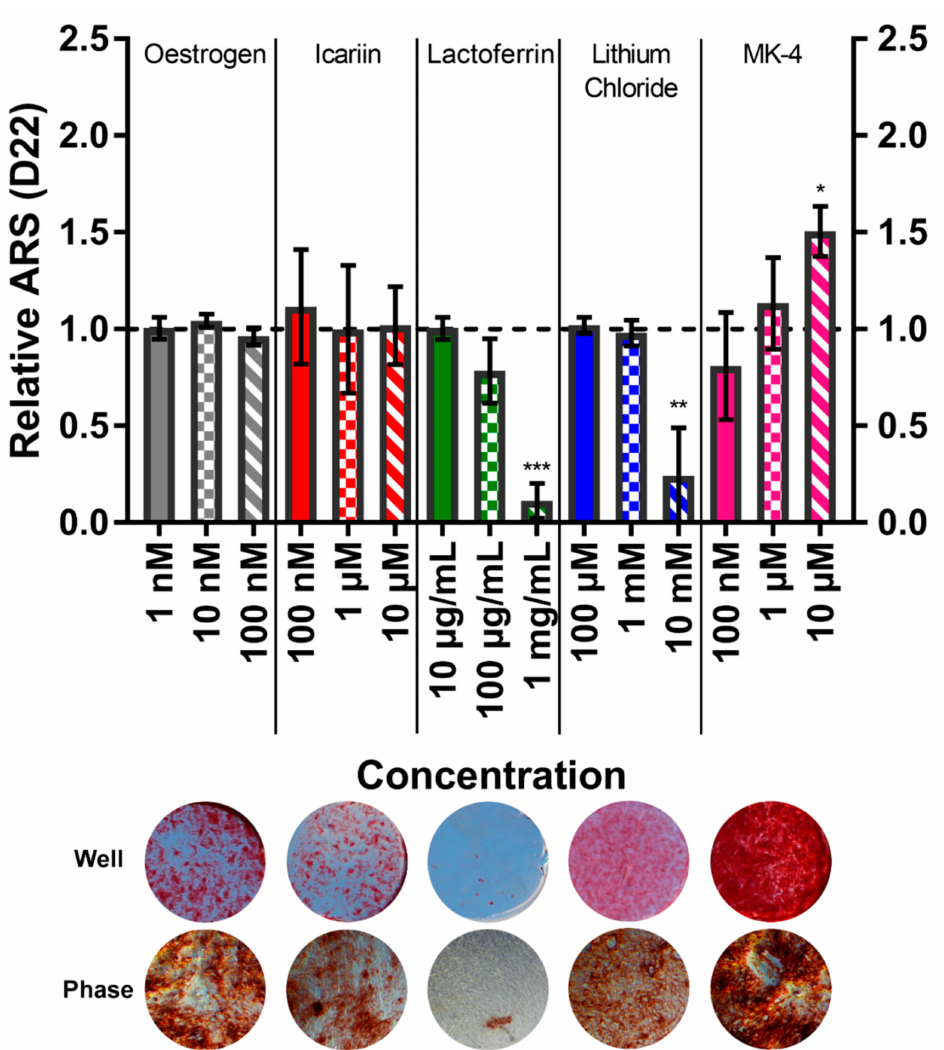
Figure 6. ( Top ) The e ff ect of each compound and concentration on the calcium deposition at day 22, normalised to their respective vehicle control (horizontal dashed line). The treatment with lactoferrin (1 mg / mL) and lithium chloride (10 mM) resulted in a significantly lower calcium deposition in comparison to the vehicle control (p < 0.001 & p < 0.01, respectively), whilst the MK-4 (10 µ M) treatment resulted in a 50% greater calcium deposition (both p < 0.05). No other condition significantly deviated from the vehicle control. (n = 8). ( Bottom ) Representative whole well images (diameter ~15 mm) and high magnification (40 × ) phase contrast images (diameter 200 µ m) of ARS staining of each compound at the highest concentration